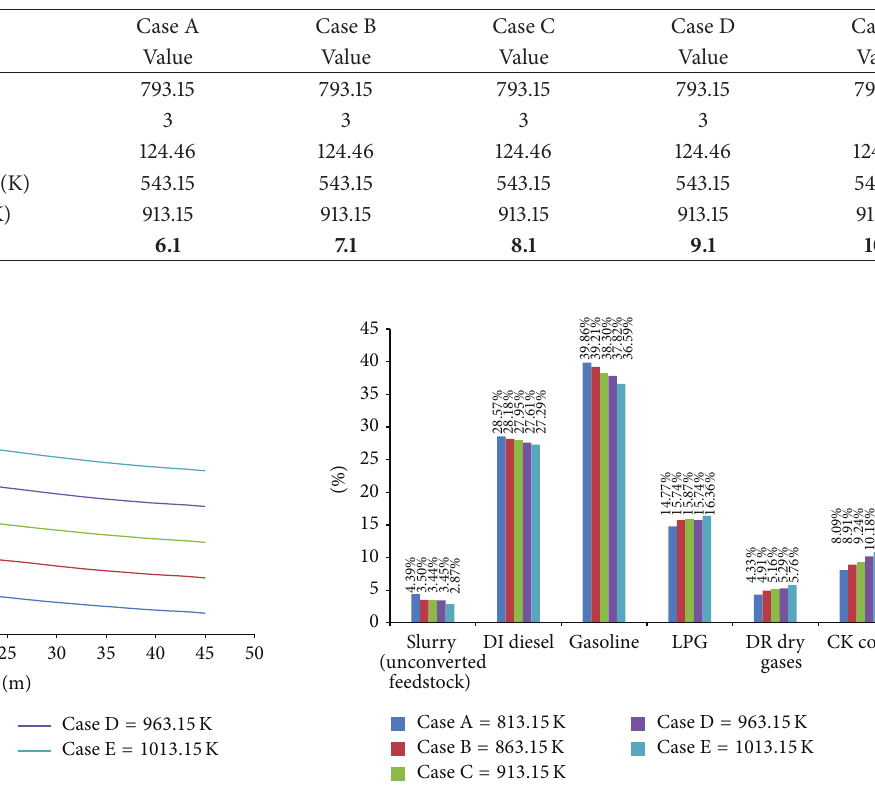
Table 8: Operating conditions with variations in catalyst-to-oil ratio.